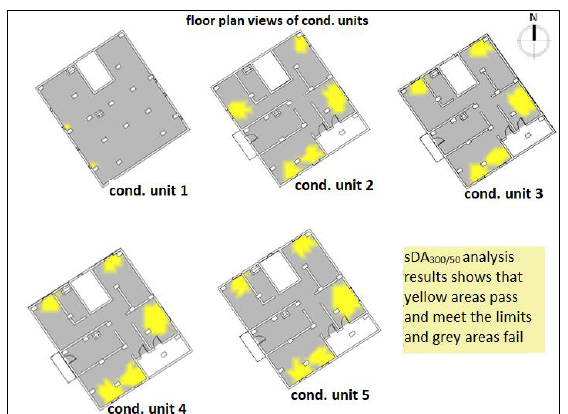
Figure 5. Visual sDA 300/50% results (building interior filled with